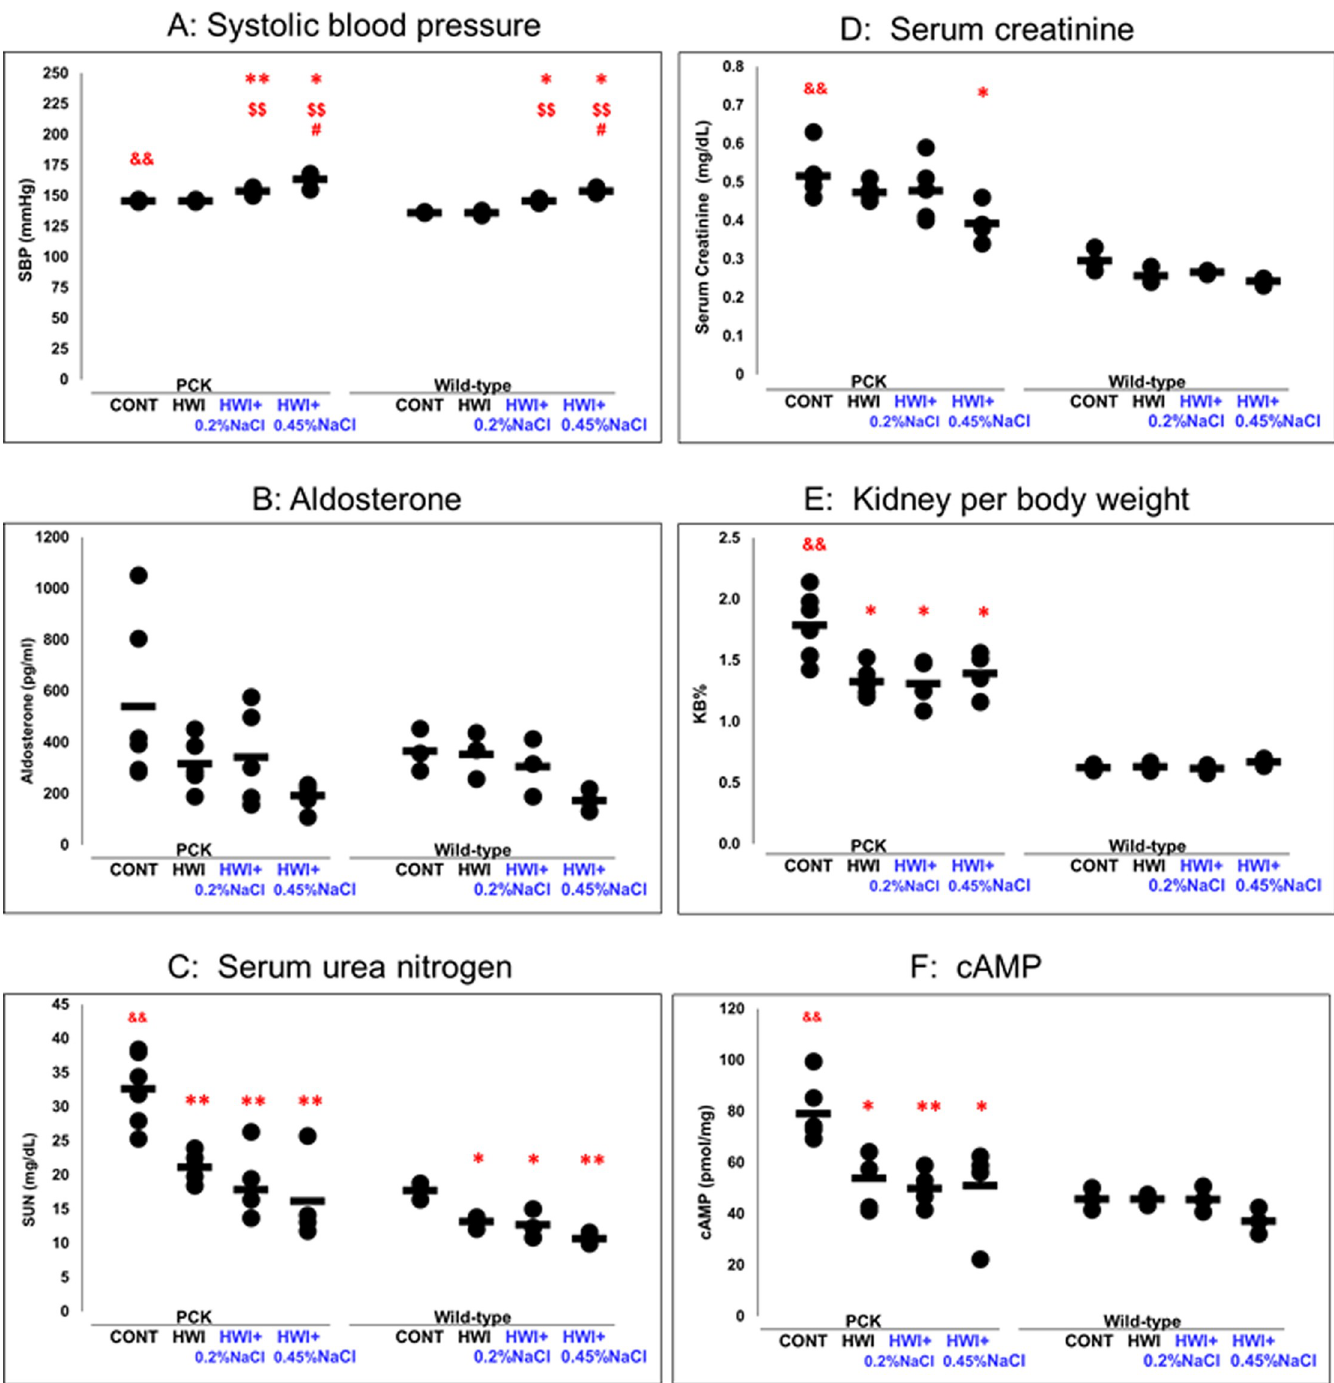
Fig 3. Effects of HWI and NaCl overload on SBP, aldosterone, SUN, serum creatinine, KB%, and renal cAMP. CONT, distilled water group; HWI, high water intake group (5% glucose); HWI+0.2%NaCl, high water intake with 0.2% NaCl group; HWI+0.45%NaCl, high water intake with 0.45% NaCl group. Difference between PCK CONT and wild-type CONT groups: &&, P < 0.01. Comparison between CONT and treated groups: � , P < 0.05; �� , P < 0.01. Comparison between HWI and HWI +0.2%NaCl or HWI+0.45%NaCl: $$, P < 0.01. Comparison between HWI+0.2%NaCl and HWI+0.45%NaCl: #, P < 0.05.